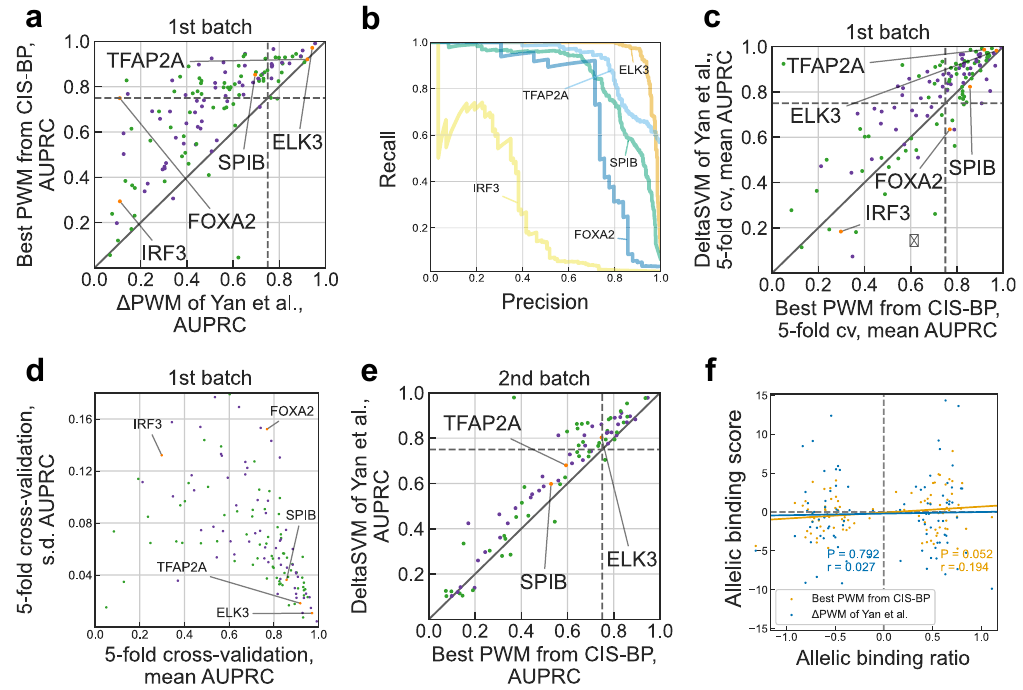
Figure 2. Re-evaluation of position weight matrices with the SNP-SELEX data. a. Comparison of performance of Yan et al . Δ PWM (x-axis) and best CIS-BP position weight matrices (PWMs) in predicting preferential binding SNPs in the 1st batch on the SNP-SELEX data. Each point denotes one of 129 TFs, violet and green points denote inferred and direct PWMs, respectively (see the Methods). Both axes show area under the precision-recall curve (AUPRC) values.Transcriptionfactors(TFs)showninFigure2bofYan etal .arehighlightedinorangeandlabeled.Dashedlines denote AUPRC of 0.75. b. Examples of the precision-recall curves showing performance of different PWM models in predictingpreferentialbinding SNPs(single-nucleotide polymorphisms)asin Figure2b ofYan etal .c.Comparisonof performance of deltaSVM (y-axis) and best CIS-BP PWMs (x-axis) in predicting preferential binding SNPs identified in the 1st batch of SNP-SELEX. Each point denotes one of 129 TFs, violet and green points denote inferred and direct PWMs, respectively. Both axes show mean AUPRC values obtained by 5-fold cross-validation (cv). Dashed lines denote AUPRC of 0.75. d. Variance of performance of CIS-BP PWMs (x-axis: mean AUPRC, y-axis: s.d.) in 5-fold cross- validationusingthecompletedataofthe1stbatchofSNP-SELEX.Eachpointdenotesoneof129TFs,violetandgreen points denote inferred and direct PWMs, respectively. e. Comparison of performance of deltaSVM (y-axis) and best CIS-BP PWMs (x-axis) in predicting preferential binding SNPs identified in the 2nd batch of SNP-SELEX. Each point denotes one of 87 TFs, violet and green points denote inferred and direct PWMs, respectively. Both axes show AUPRC values. Dashed lines denote AUPRC of 0.75. f. Correlation of allelic biases of DNA binding detected